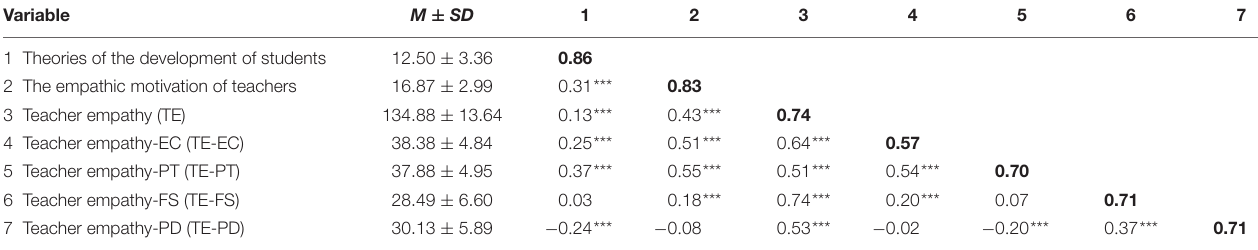
TABLE 1 | Descriptive statistics and partial correlations for key